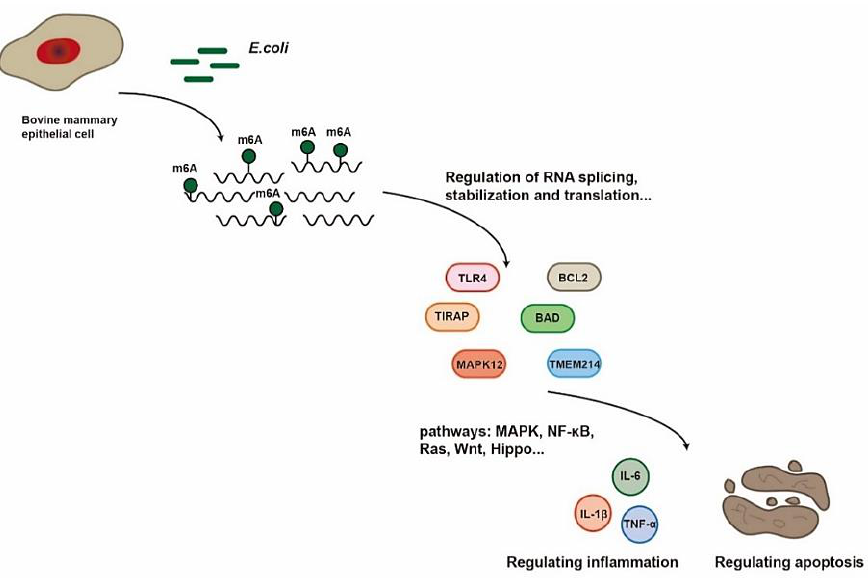
Figure 6. Sketch showing the potential pathways for MAC-T cells treated with the E. coli .